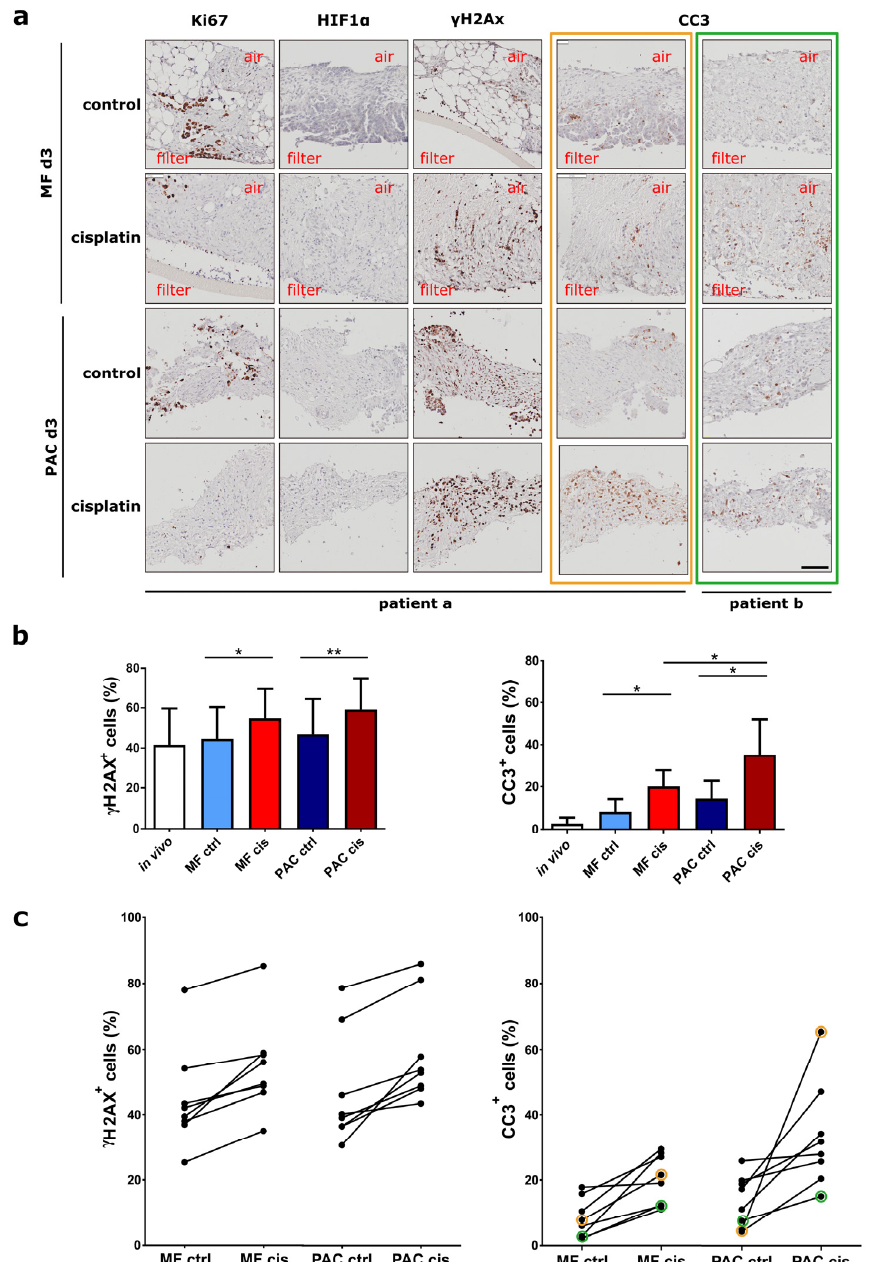
Figure 9. Treatment of cisplatin on primary ovarian tumor slices. ( a ) The primary ovarian tumor slices were incubated with cisplatin for 3 days in both the Millipore filter (MF) system or the perfusion air culture (PAC) system. Cisplatin treatment did not influence Ki67 and HIF1 α expression in primary ovarian tumor slices. A minor increase in γ H2AX was observed in both MF and PAC systems. Different patient tumors (marked with orange and green with frames) showed different CC3 expression, while only in the PAC system was strongly enhanced CC3 observed. The scale bar represents 100 µm. ( b ) The overall percentage of positive cells expressing γ H2AX and CC3 on MF and PAC systems after 3 days culture without (ctrl) and with cisplatin (cis) treatment from eight patient experiments. ( c ) The percentage of positive cells expressing γ H2AX and CC3 after 3 days culture for each patient without (ctrl) and with cisplatin (cis) treatment (n = 8) in the Millipore filter (MF) system or the perfusion air culture (PAC) system. The two black dots connected by a straight line in the figure are from the experiment of one patient. The orange and green circles in CC3 expression indicate the corresponding patients in Figure ( a ) marked with orange and green frames. (* p -value < 0.05, ** p -value <